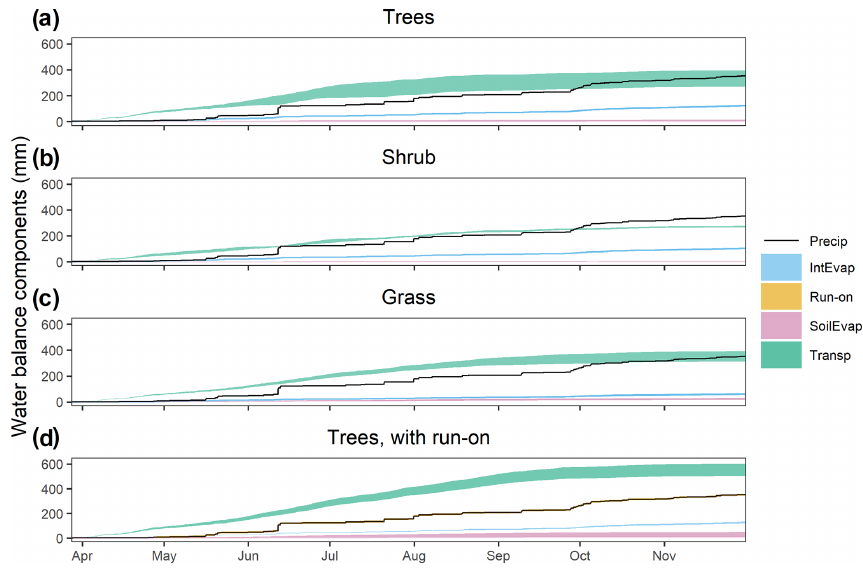
Figure 8. Cumulative precipitation (Precip), evaporation from intercepted water (IntEvap), run-on, evaporation from soil water (SoilEvap) and transpiration (Transp) for trees (a) , shrub (b) , grass (c) and trees with run-on from adjacent sealed surface (d) .